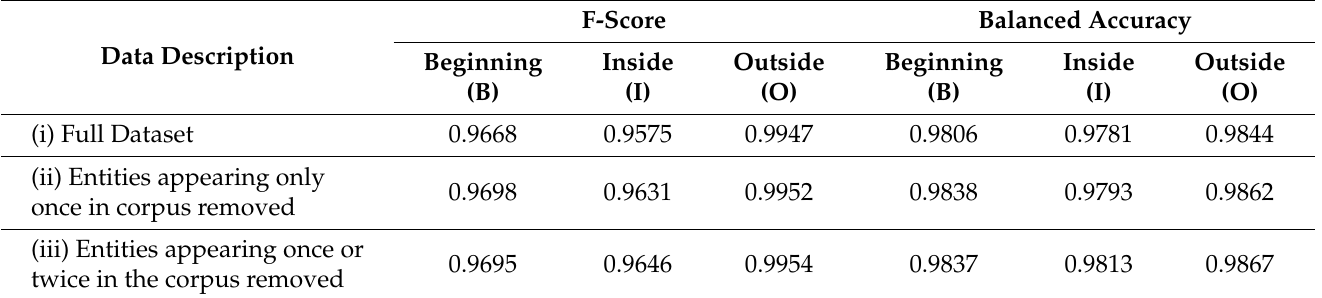
Table 4. F-score and balanced accuracy for detecting term-boundaries using the IOB-segment rep- resentation. The meaning of IOB corresponds to (B)—beginning token of a named entity, (I)—any named entity token that comes after B, (O)—all other tokens that are not named entities. Evaluations are performed for (i) full corpus data, (ii) data with entities removed that appear just once and (iii) data with entities removed that appear just once or